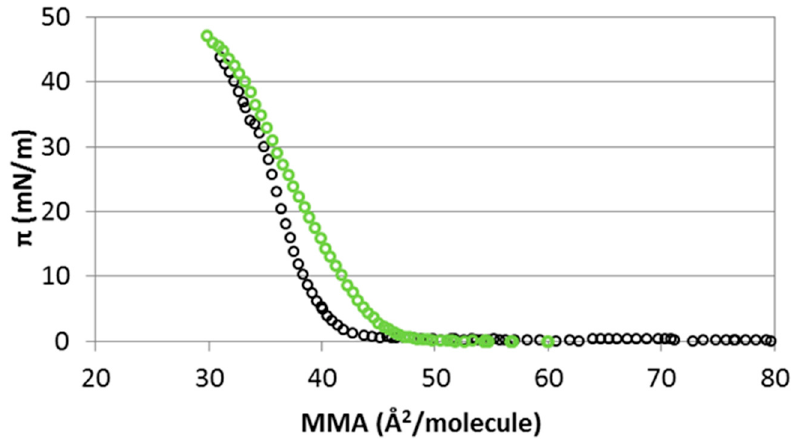
Figure 7. Isotherm of surface pressure ( π ) vs. area per molecule (MMA) of CHOL monolayers in a 15 mM subphase of monovalent salts (NaCl black open circles and NaI green open circles) (standard deviation <2%).